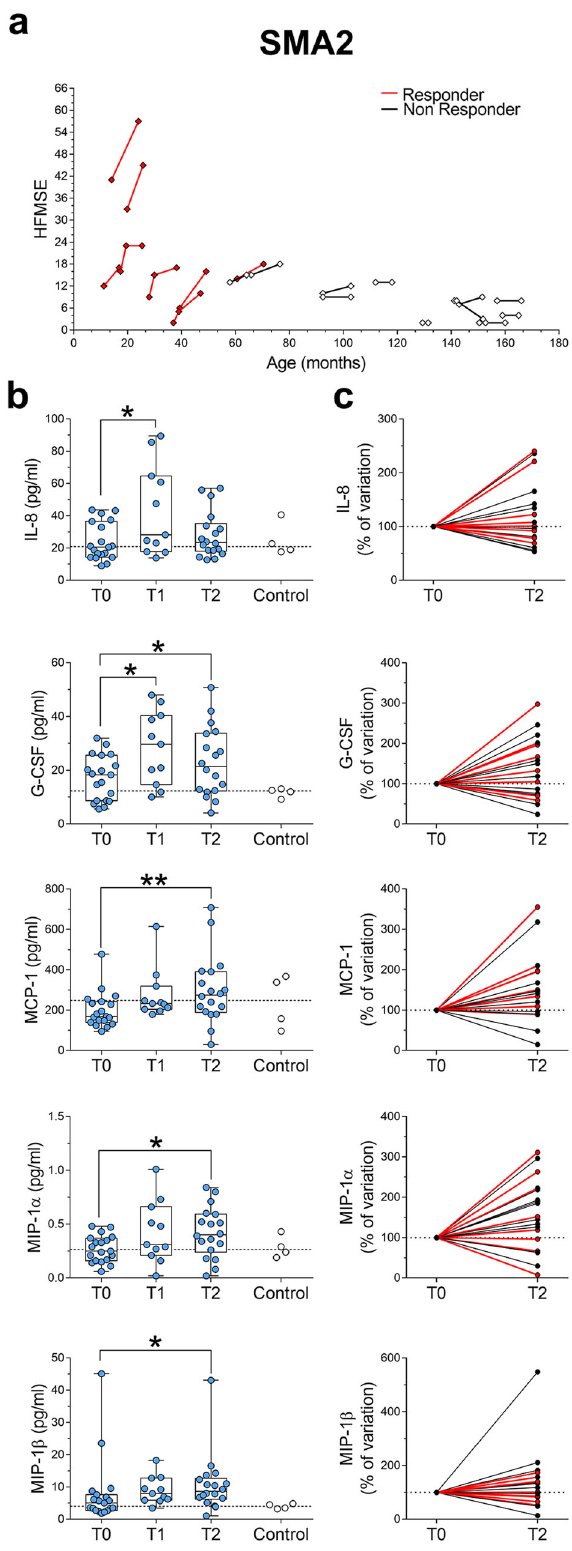
(IL-1ra), respectively. These neuroin fl ammatory outcomes may represent possible side-effects of Nusinersen in milder SMA patients. However, our results do not highlight a correlation between differences in the levels of these cytokines and speci fi c changes in motor function of SMA2 and SMA3 patients assessed by the HFMSE. Considering also that signi fi cant adverse effects